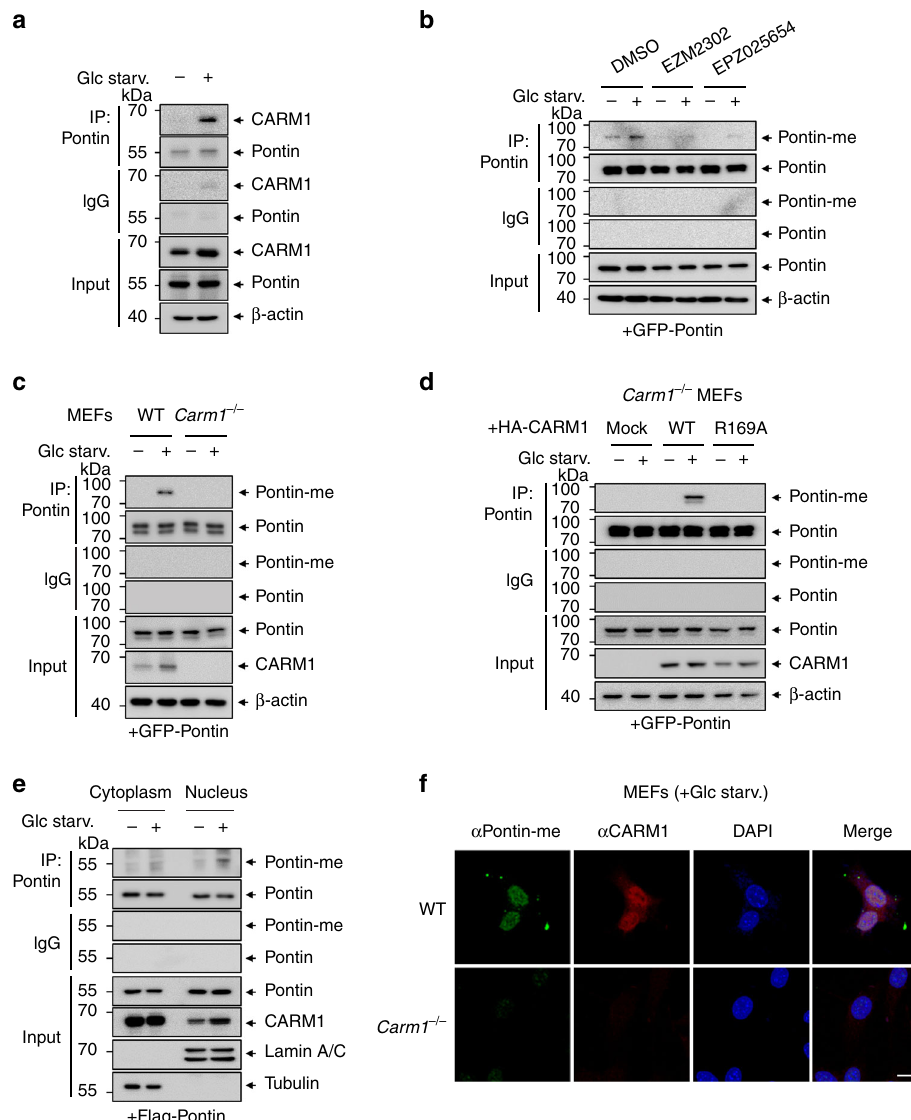
Fig. 2 Pontin is arginine methylated by CARM1 in the nucleus upon glucose starvation. a Co-immunoprecipitation assay with Pontin and CARM1 in HeLa cells under glucose starvation for 18 h. b Pontin methylation in MEFs under glucose starvation was analyzed after treatment of CARM1-speci fi c inhibitors, EZM2302 (100 nM) and EPZ025654 (100 nM) for 96 h. c Pontin methylation was evaluated in WT or Carm1 − / − MEFs following glucose starvation. d Pontin methylation was assessed in Carm1 − / − MEFs reconstituted with CARM1 WT or R169A mutant. e Pontin methylation was assessed in MEFs after nuclear and cytoplasmic fractionation. f Representative confocal images of methylated Pontin and CARM1. Scale bar, 20 μ m. Source data are provided as a Source Data fi